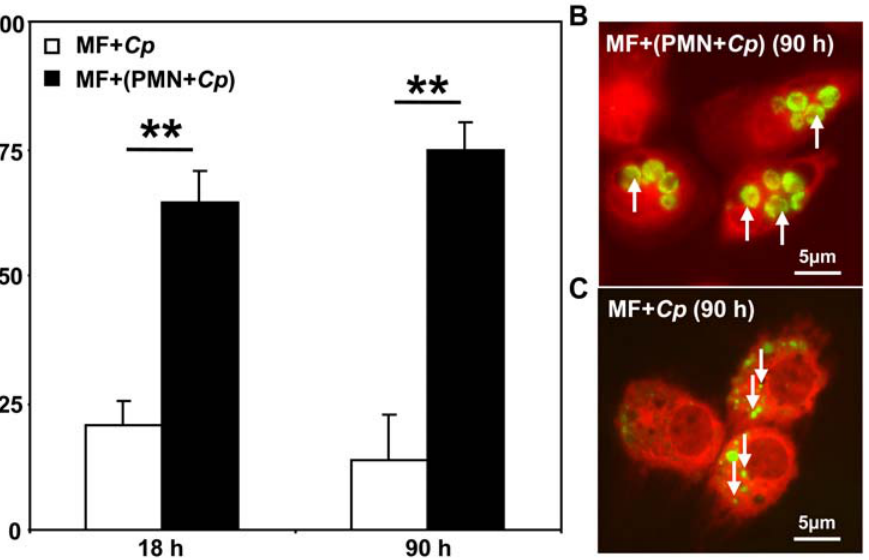
Figure 4. PMN passage increases chlamydial transmission to macrophages. C. pneumoniae alone (open bars) or C. pneumoniae - infected PMN (closed bars, 66 h p.i.) were co incubated with autologous macrophages (MF) at ratio of 1:1 ( A–C ). The amount of C. pneumoniae - positive ( C. pneumoniae LPS- staining) MF increased significantly after 18 and 90 h when MF were co incubated with C. pneumoniae - infected apoptotic PMN ( A , p=0.004), but not upon direct C. pneumoniae infection. Fluorescence microscopy revealed that co incubation of MF with C. pneumoniae - infected apoptotic PMN for 90 h resulted in multiple large inclusions ( B ) whereas directly infected MF showed smaller ‘‘persistent-like’’ inclusions ( C ; magnification 630 6 ).